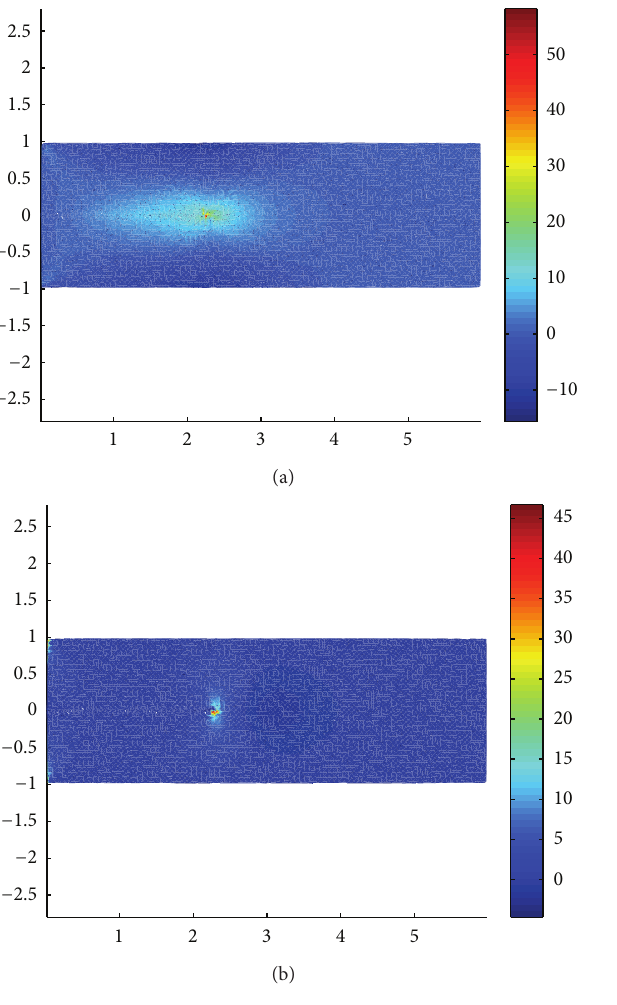
Figure 28: Stress (a) 𝜎 𝑥𝑥 and (b) 𝜎 𝑦𝑦 contours in the sheet (unstructured mesh) after the crack